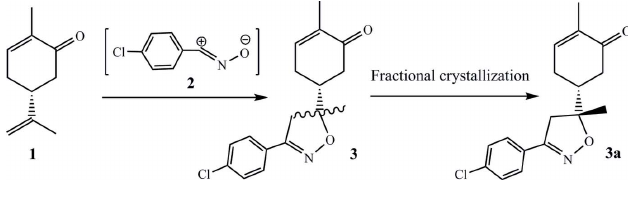
Figure 3 Synthesis pathway leading to the formation of the title compound, 3a